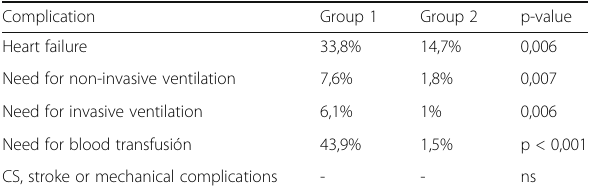
Table 2 (abstract 000535). In-hospital complications and mortality